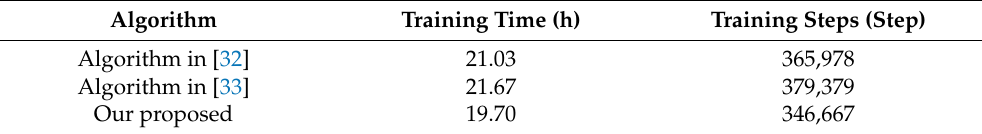
Table 10. Comparison of training time and steps of each algorithm in simulation Figure 6b.